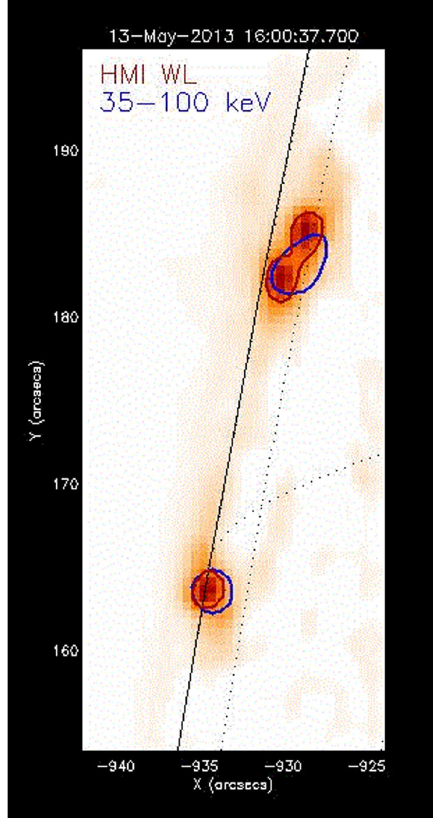
Fig. 25 Still from a movie: A white-light flare near the solar limb. The RHESSI hard X-ray (30–50 keV, blue ) contours are overlaid on a white-light difference (background and red ) image observed by HMI/SDO. Note spatial coincidence of hard X-ray and white-light brightenings. Image courtesy of Säm Krucker, for details see Martínez Oliveros et al.